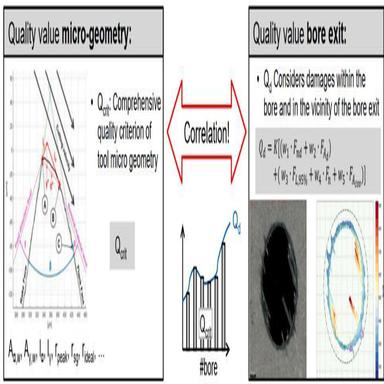
Correlation between wear dependent micro geometry of the tool and the bore hole quality parameter Qd.